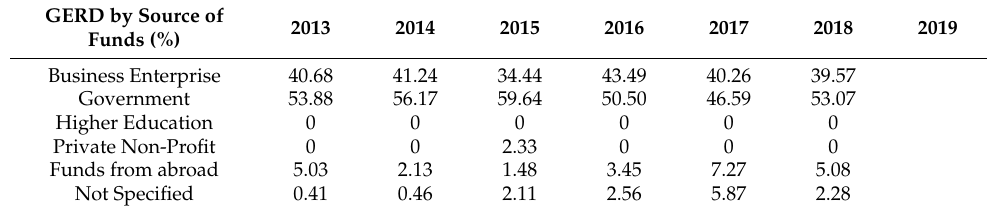
Table 1. Gross Domestic Expenditure on R&D (GERD) in Sri Lanka. GERD by Source of Funds